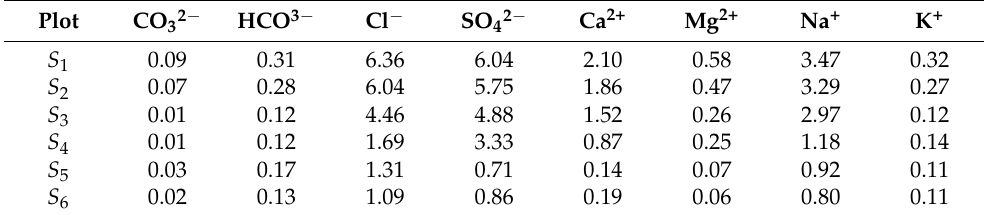
Table 5. Contents (grams/litre) of eight main salt ions in soils irrigated with water at different salinity levels. Plot CO 32 − HCO 3 − Cl −